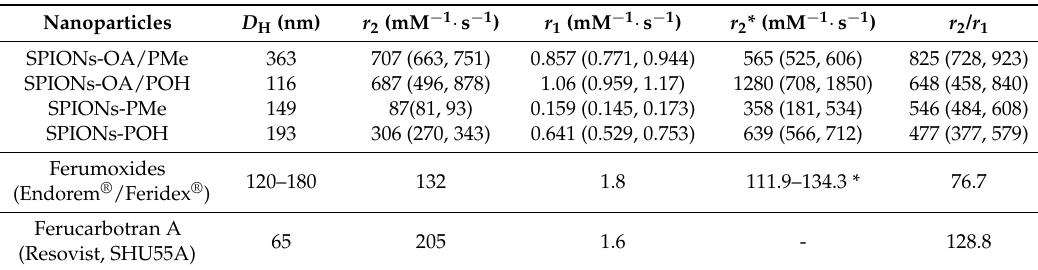
Table 1. Hydrodynamic diameter ( D H ), and relaxivities ( r ) with 10% confidence intervals for select SPIONs and water-dispersible SPIONs measured at